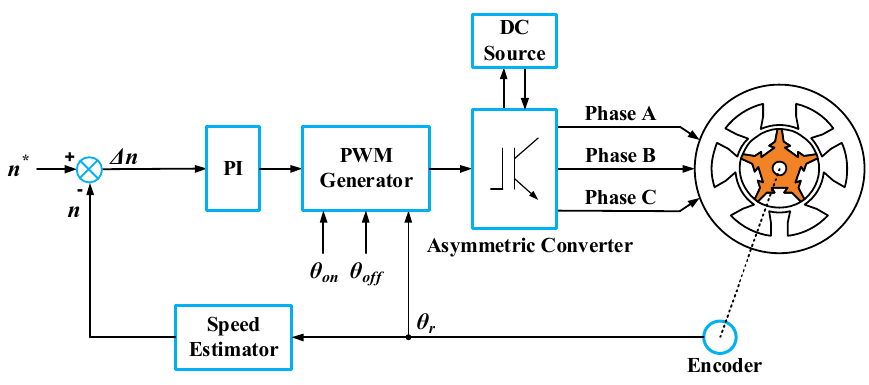
Figure 11. Control scheme for the two motors.